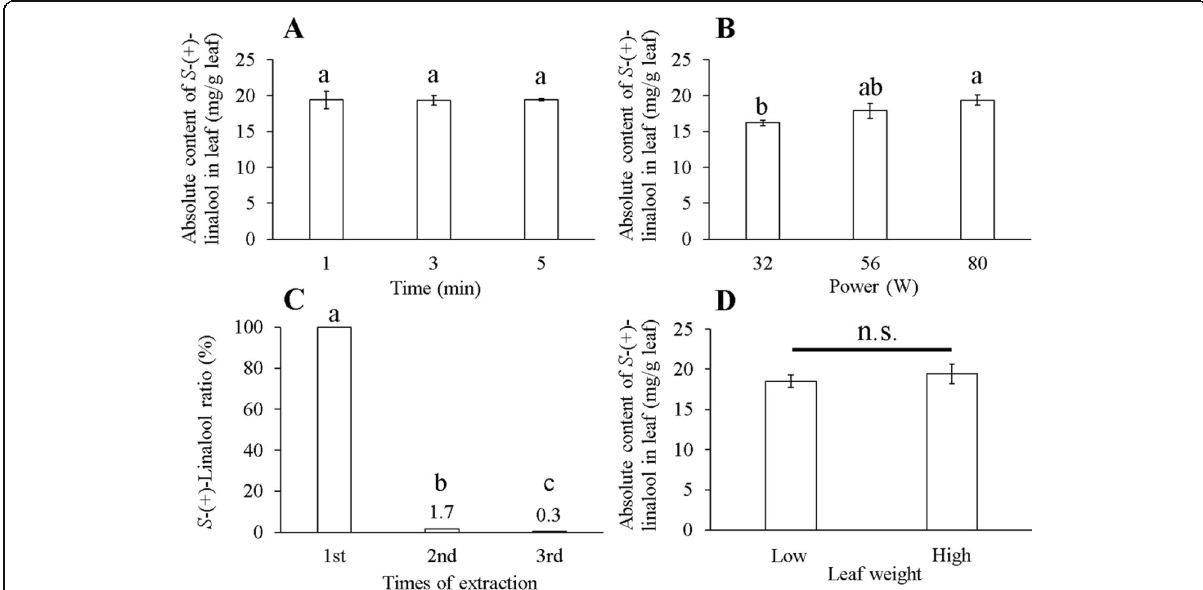
Fig. 1 Effects of four extraction conditions on absolute content and ratio of S -(+)-linalool extracted from leaf. a Different ultrasonic extraction time (min) (25 mg of leaf was extracted once using ultrasonic power of 80 W). b Power (W) of ultrasound (25 mg of leaf was extracted once for 1 min). c Times of extraction (25 mg of leaf was extracted using ultrasonic power of 80 W for 1 min). d Leaf weight (low: 10 ± 1 mg; high: 25 ± 1 mg) (leaf was extracted once using ultrasonic power of 80 W for 1 min). Data were presented as mean ± SD ( n = 3). Different letters are significantly different at the level of p < 0.05 according to one-way ANOVA and Scheffe ’ s test. n.s. represents no significantly different when compared with each other by Students ’ s t test ( p <